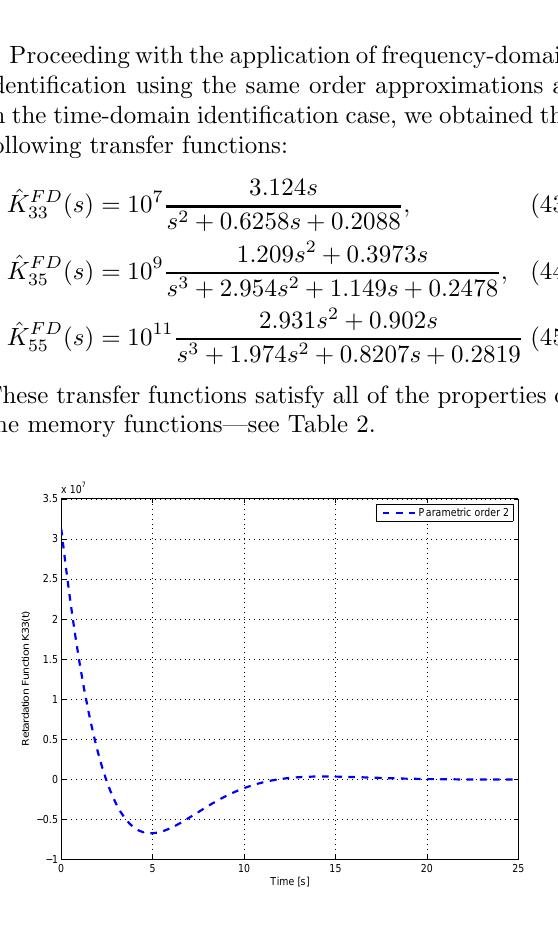
Figure 10: ˆ K 33 ( t ) based on frequency response curve fitting.